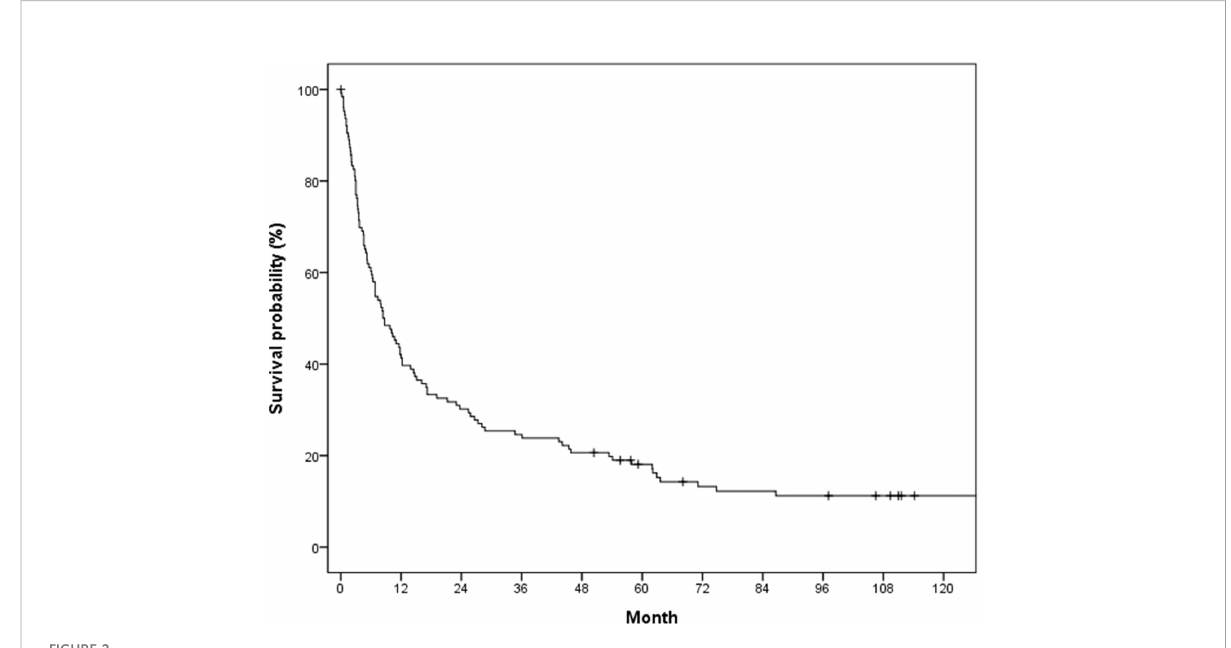
FIGURE 2 Overall survival in the study